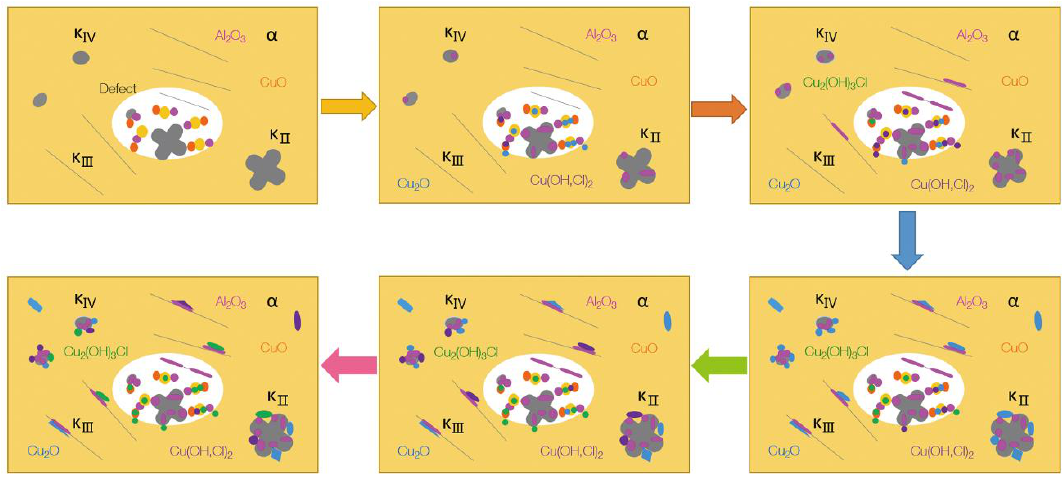
Figure 14. Process mechanism of corrosion behavior of S-Defect immersed in artificial seawater.